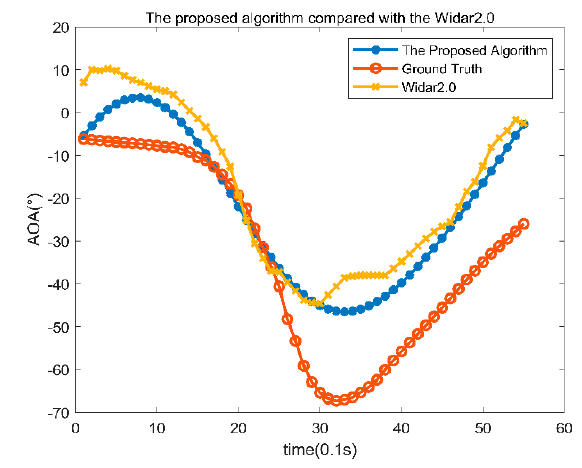
Figure 9. AOA results of office T02 data.